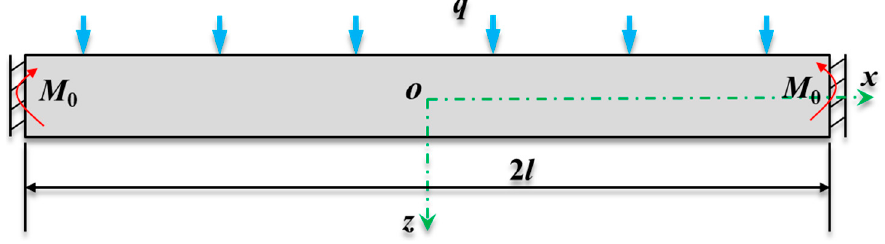
Figure 11. Segmented roof deformation.